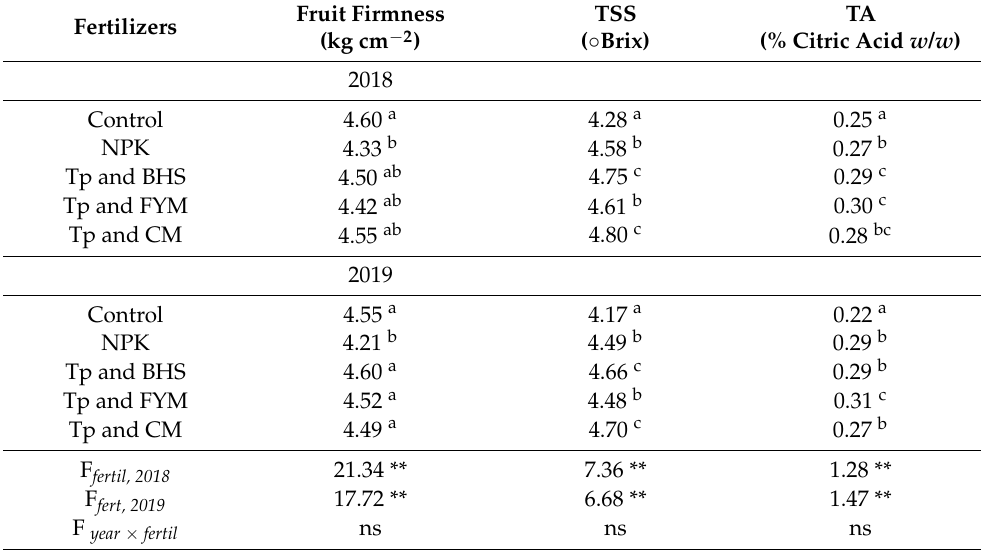
Table 4. Quality characteristics as affected by fertilizer treatments (control, NPK, Tp and BHS, Tp and FYM, and Tp and